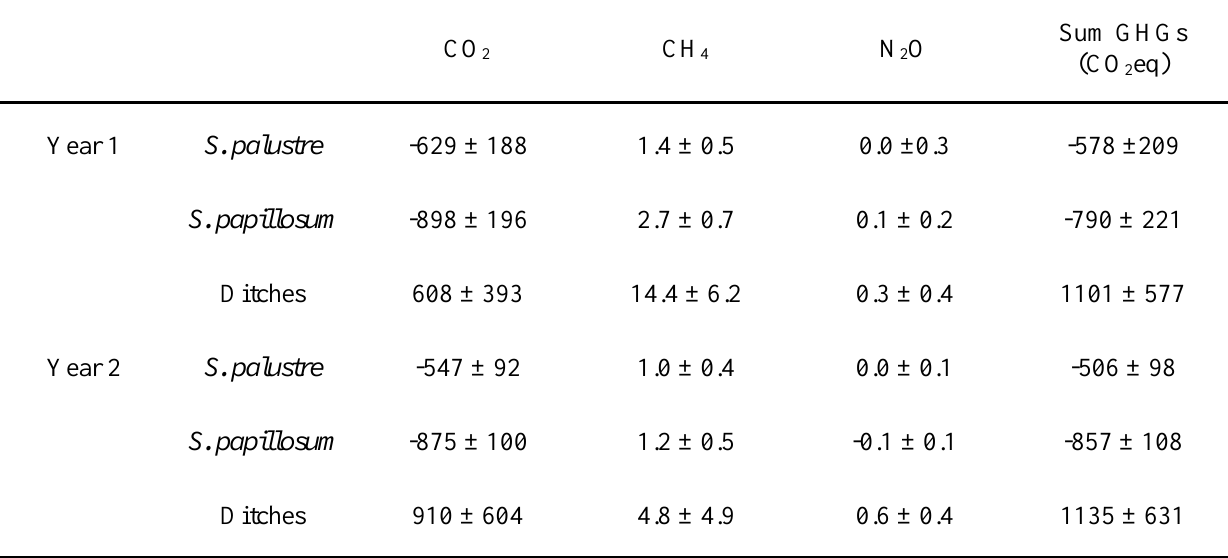
Table 2. Estimated annual balances of CO 2 , CH 4 and N 2 O together with combined climatic effect (all in g m -2 ) for the production strips and irrigation ditches. Values are given ± SE. Note that the annual balances of the GHGs refer to the released mass of gas, while the combined balances of all gases have been converted to CO 2 -